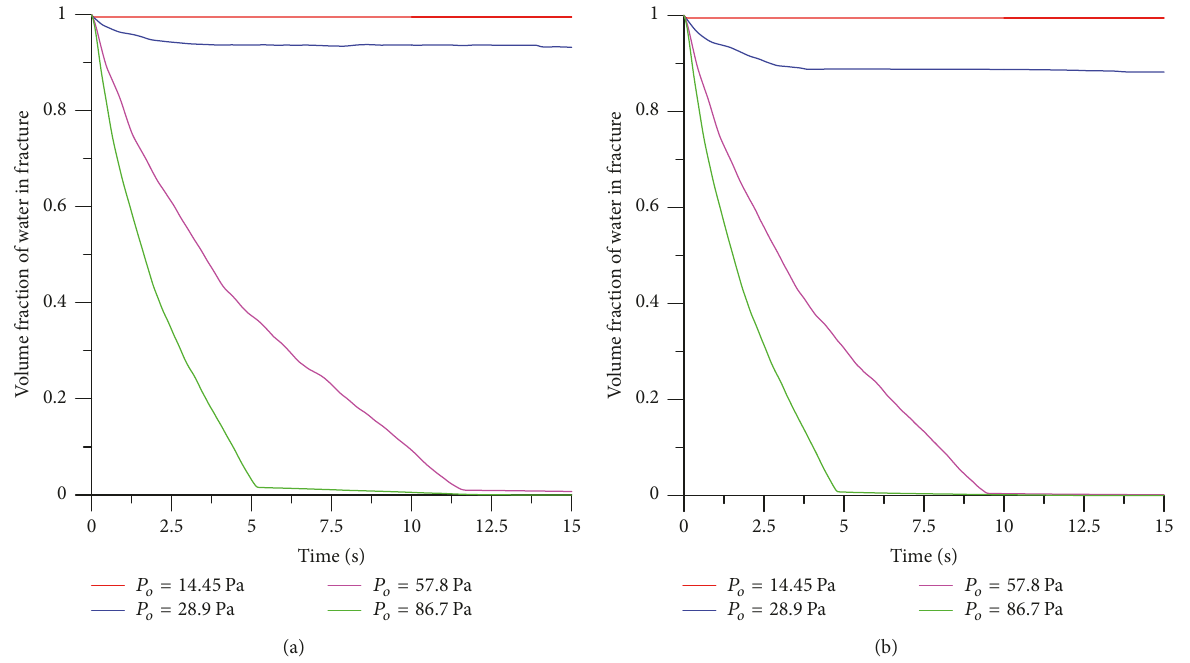
Figure 11: Volume fraction of water in the fracture for different wettability setting for fracture wall: (a) FD = 2.0, contact angle 30 ∘ ; (b) FD = 2.0, contact angle 60 ∘ .